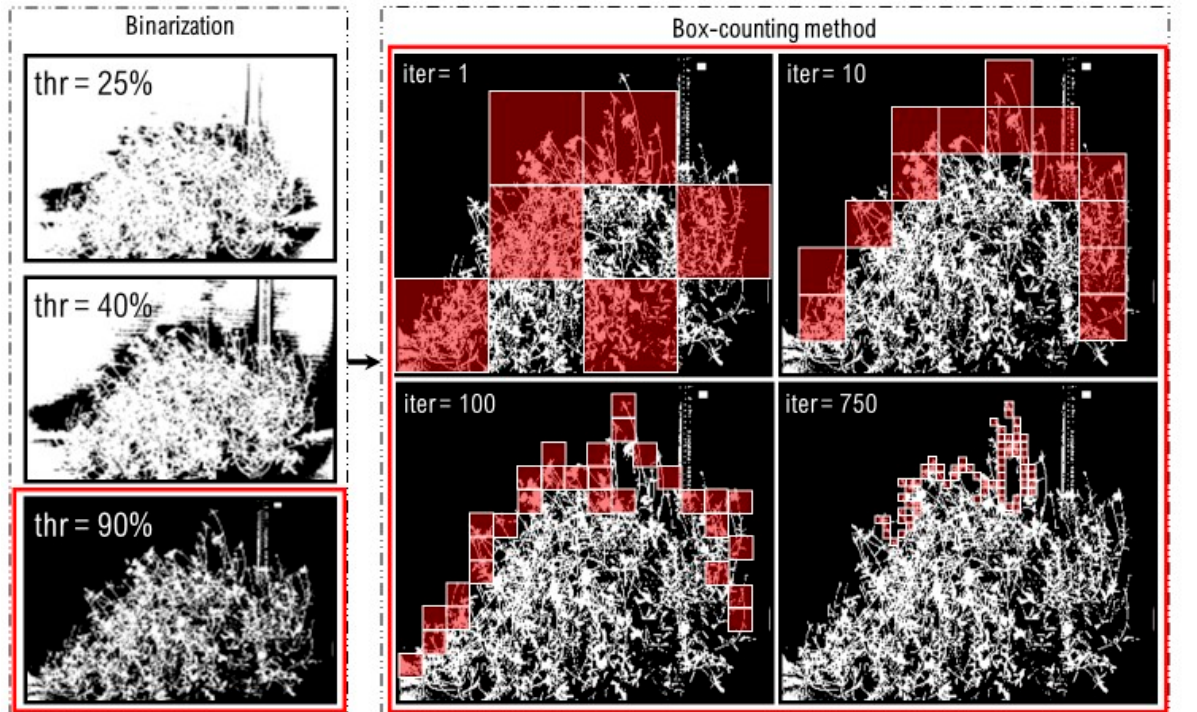
Figure 1. Example of binarizing a 24-bit-color image into a collection of pixels in black and white to determine the fractal dimension of the architecture of P. umbraticola . The set of thresholds (thr) for the binarization is defined automatically between 5–95% of the highest intensity values of pixels, with an interval of 5% for standardization. The best output of binarization becomes the input for the determination of the fractal dimension of the external shape of P. umbraticola through BCM. The box-counting algorithm processes the image iteratively (iter) until it completely covers the pattern at the border or region of interest to precisely describe the external shape, as opposed to global measures to describe the entire subject of analysis.